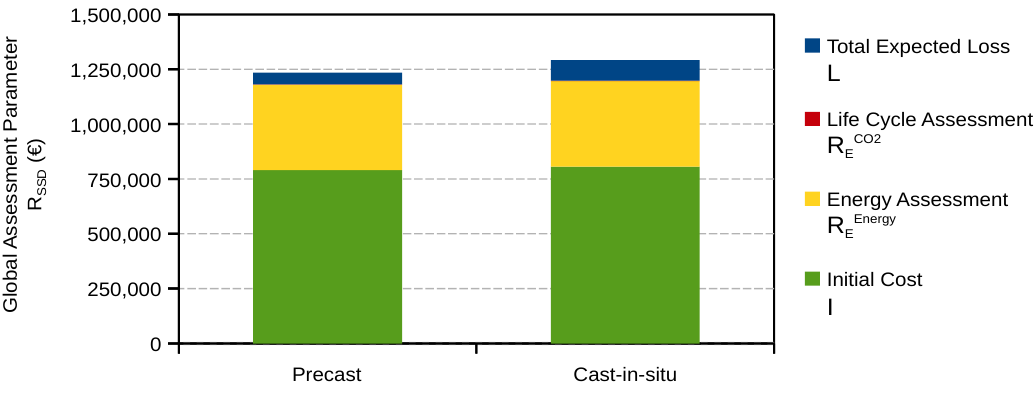
Figure 12. Results comparison of the Global Assessment